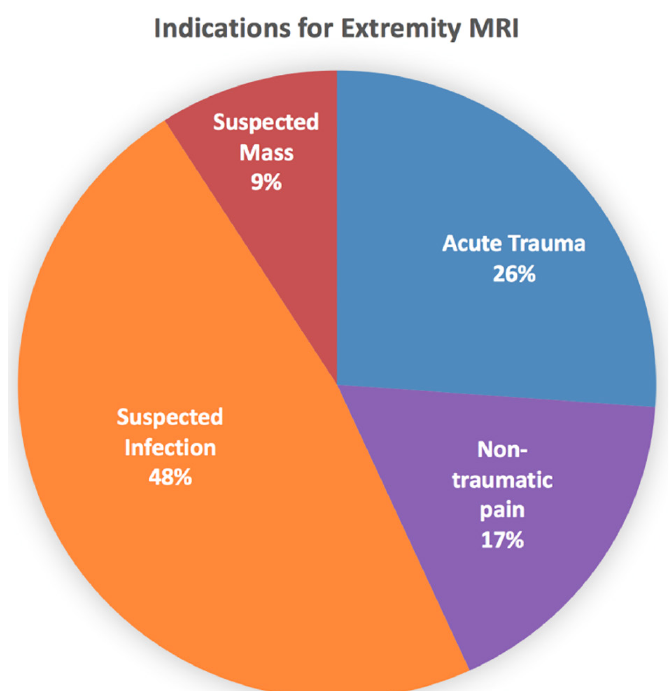
Figure 1. Distribution of indications for musculoskeletal extremity magnetic resonance imaging (MRI) in the emergency department observation unit.